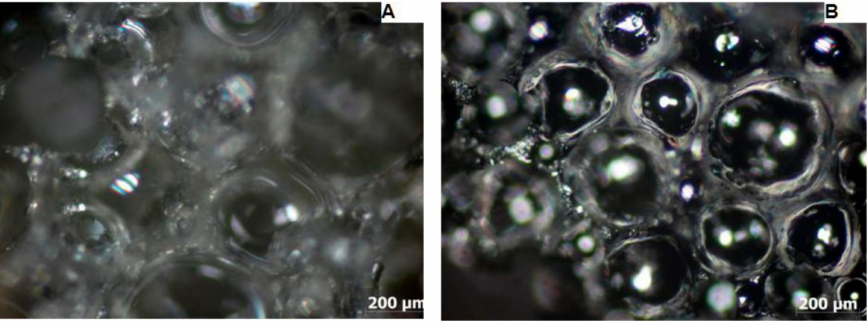
Figure 5. Micrograph of PUR foam ( A ) and carbon foam ( B ) taken with a light microscope-sample M1.